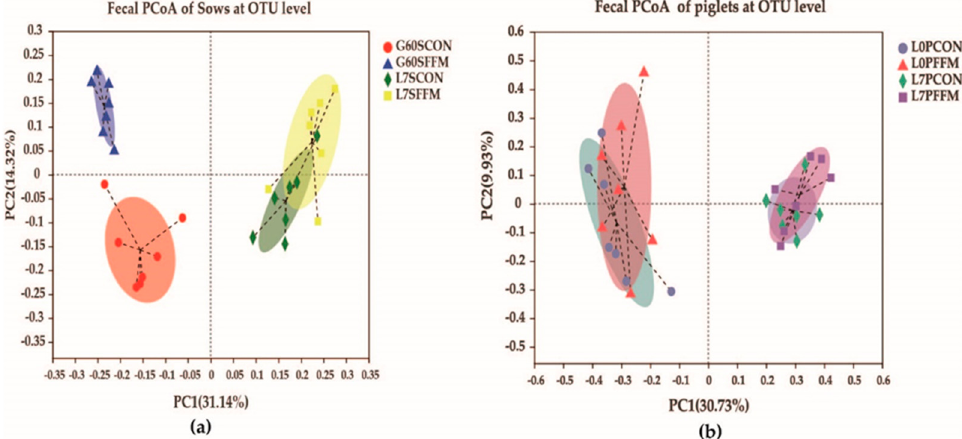
Figure 4. Effects of FFM supplementation shown by the unweighted Unifrac values of the fecal microbiota of sows on G60 and L7 (a) and the fecal microbiota of piglets on L0 and L7 (b) at the OTU level, as determined by the principal coordinate analysis (PCoA). The Bray-Curtis method was used for the PCoA; different colors or shapes represent different groups’ samples. The closer two sample points are, the more similar the species compositions of the two samples are. N = 7 for each stage of each group. G60SCON = CON sows on G60; G60SFFM = FFM sows on G60; L7SCON = CON sows on L7; L7SFFM = FFM sows on L7; L0PCON = CON piglets on L0; L0PFFM = FFM piglets on L0; L7PCON = CON piglets on L7; L7PFFM = FFM piglets on L7.